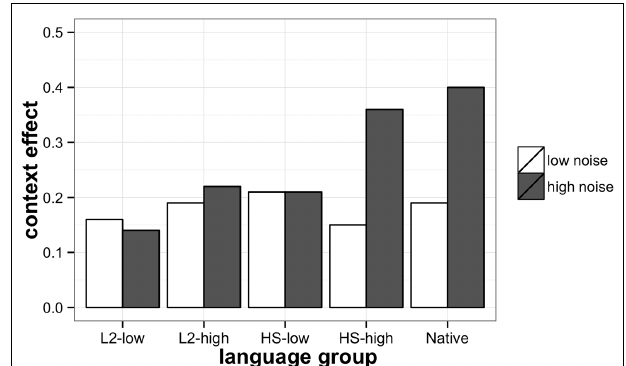
FIGURE 2 | Context effects in SPIN task for heritage, L2, and native participants. Context effect is calculated as a difference between the score in the high-predictability context condition and low-predictability context condition. 0.5 corresponds to 50% increase in accuracy in the high-predictability